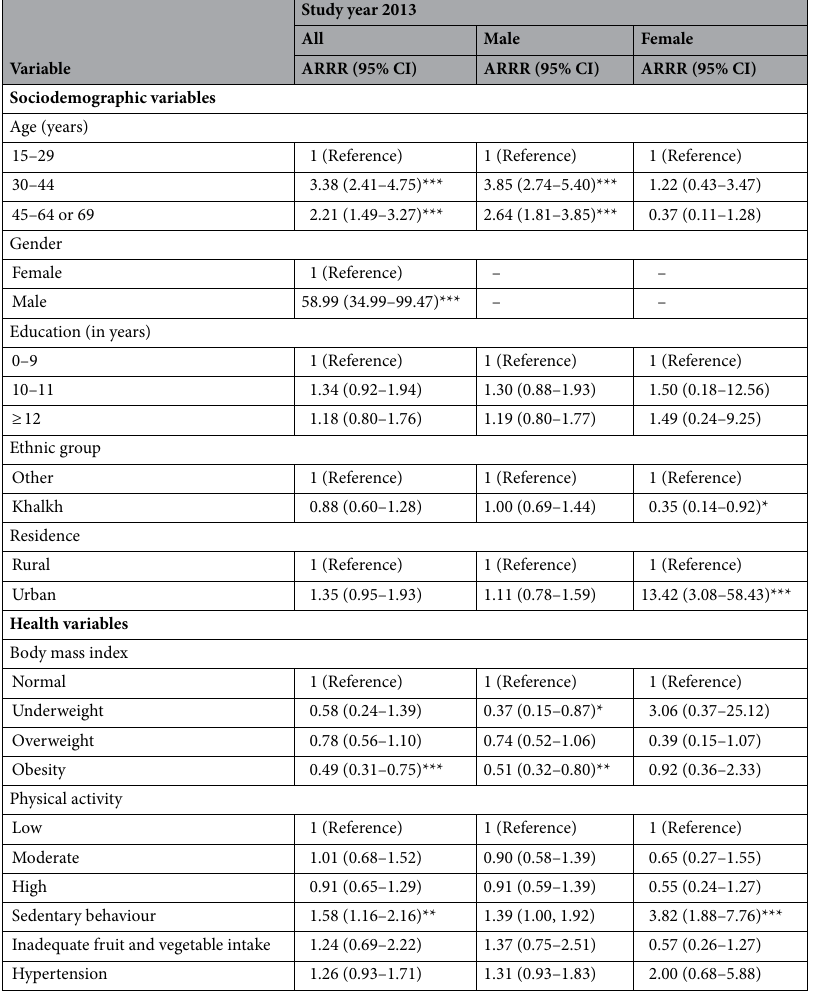
Table 17. Associations with current tobacco use and current heavy drinking (with non-current tobacco and non-current heavy drinking as reference category) among 15 years and older individuals in Mongolia,